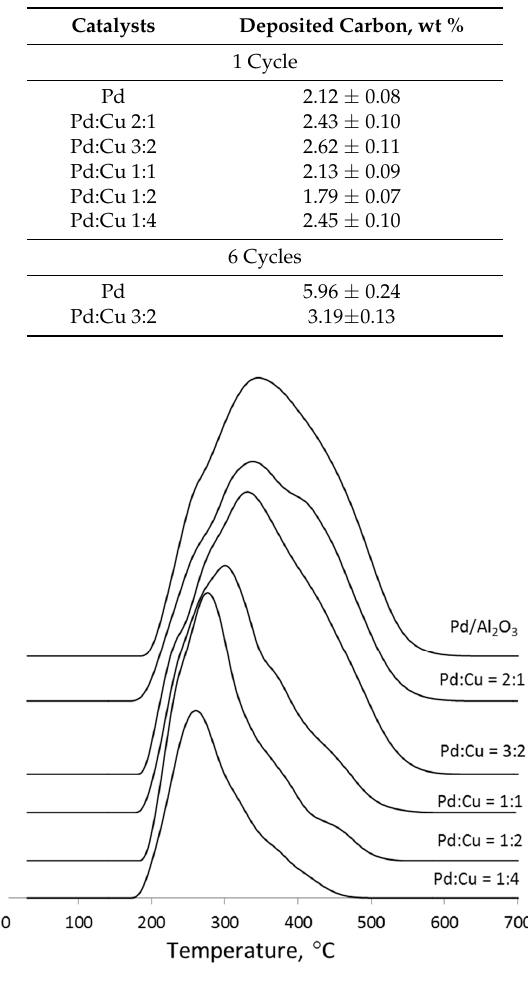
Figure 8. Temperature programmed oxidation (TPO) profiles of spent Pd ‐ Cu/Al 2 O 3 catalysts.